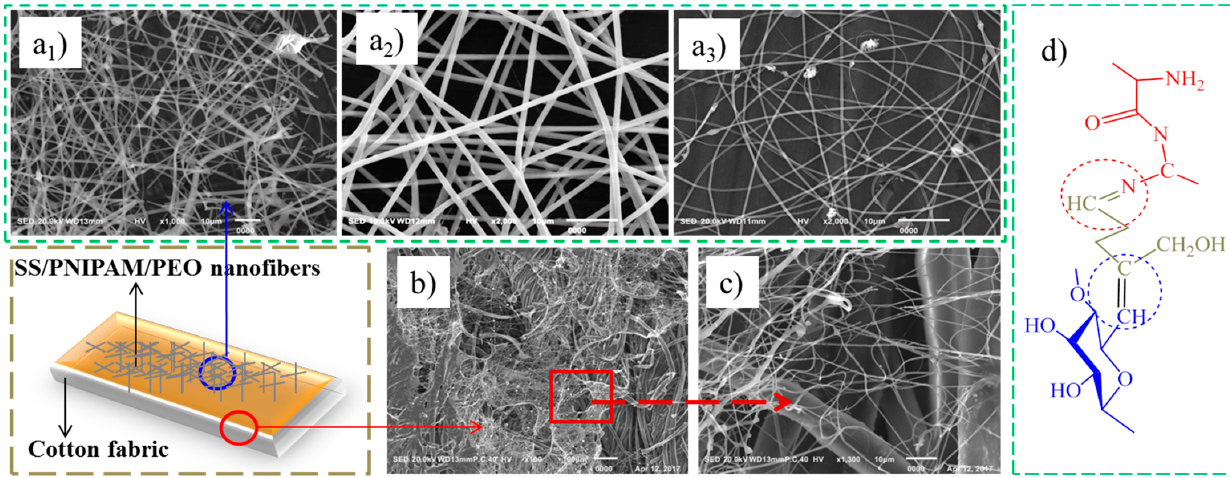
Figure 3. The morphology of ( a ) Sericin/PNIPAM/PEO nanofibers: ( a 1 25/45/30; a 2 40/30/30; a 3 55/15/30); ( b , c ) Function- alized cotton fabric; ( d ) Reaction mechanism between sericin and cotton. Functionalized cotton fabric; ( d ) Reaction mechanism between sericin and